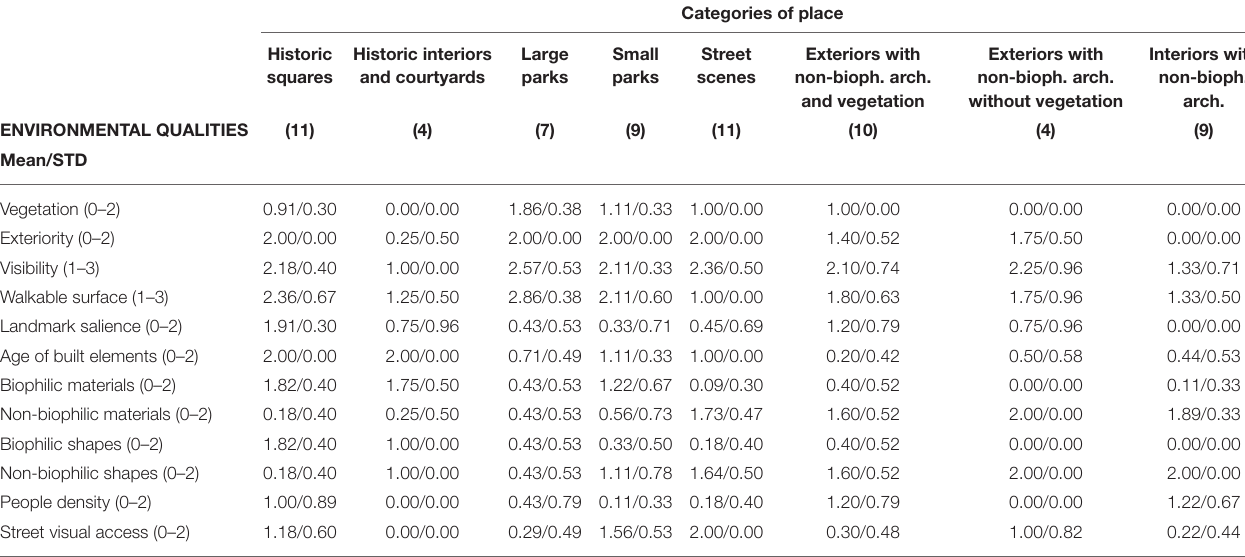
TABLE 2 | Means and standard deviations per place category of the environmental dimensions evaluations given by the panel of